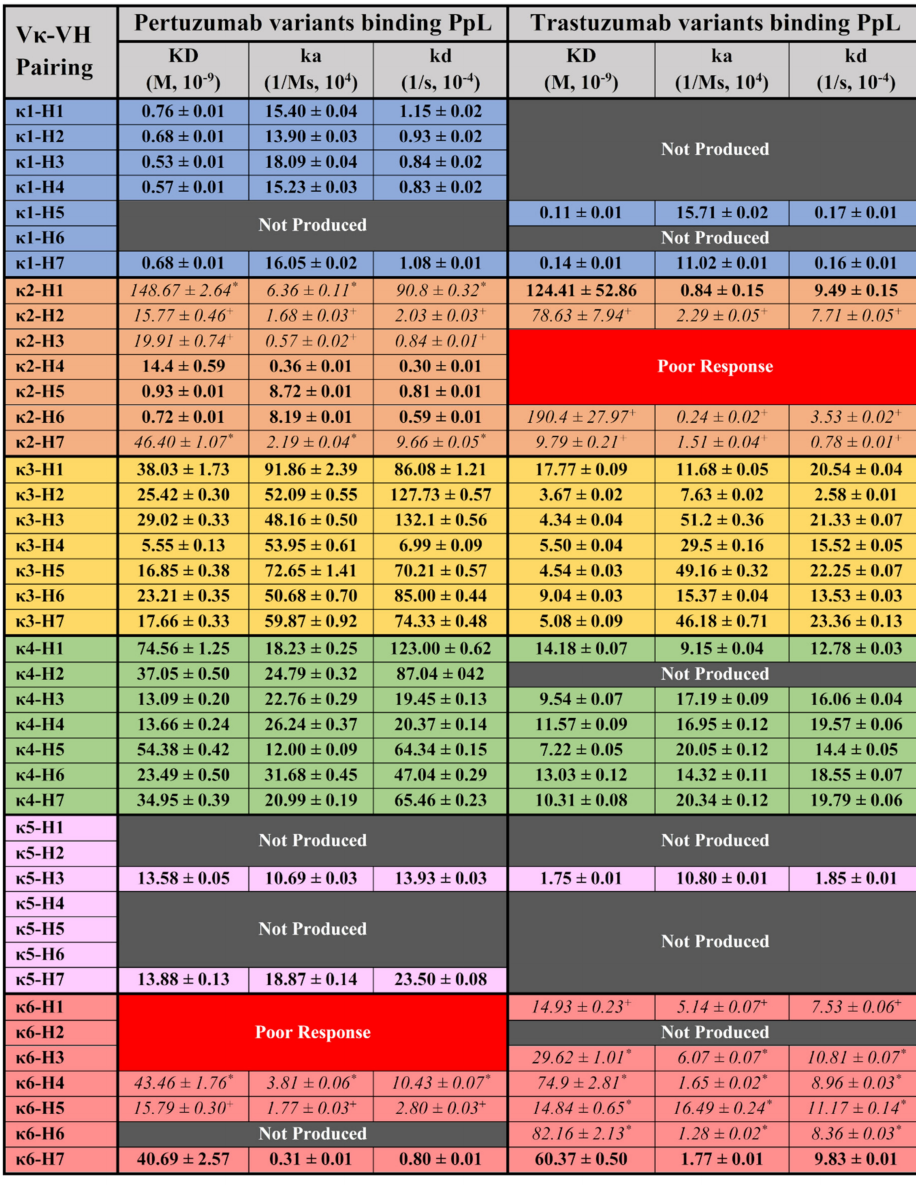
Figure 3. BLI measurements (KD, ka, and kd) of Pertuzumab and Trastuzumab V κ 1–6 and VH1–7 variants binding to the immobilised PpL biosensor. “Not Produced” denotes insufficient antibody production for the variants despite numerous large-scale transfections. “Poor response” indicates that the particular V κ -VH IgG1 pairing was unable to give response rates within the detection limit across all concentrations. * denotes readings that were derived from two IgG1 concentrations. + denotes represent readings derived from only one IgG1 concentration which was deemed reliable. All other readings were obtained from at least three antibody concentrations. The readings were the average of independent triplicates. The graphs are shown in Supplementary Figures